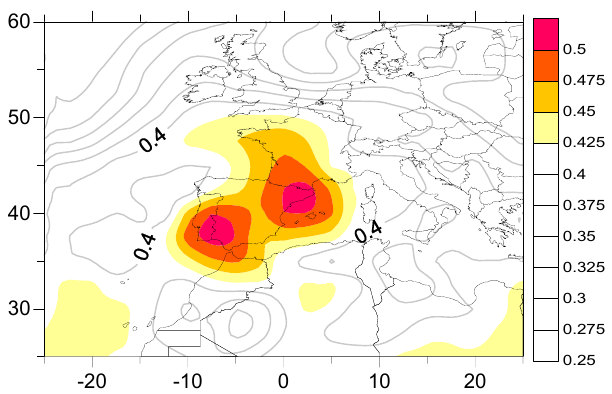
Figure 2. Maximum absolute values of the correlations between TxValencia and the relative vorticity difference between two points (daily data).